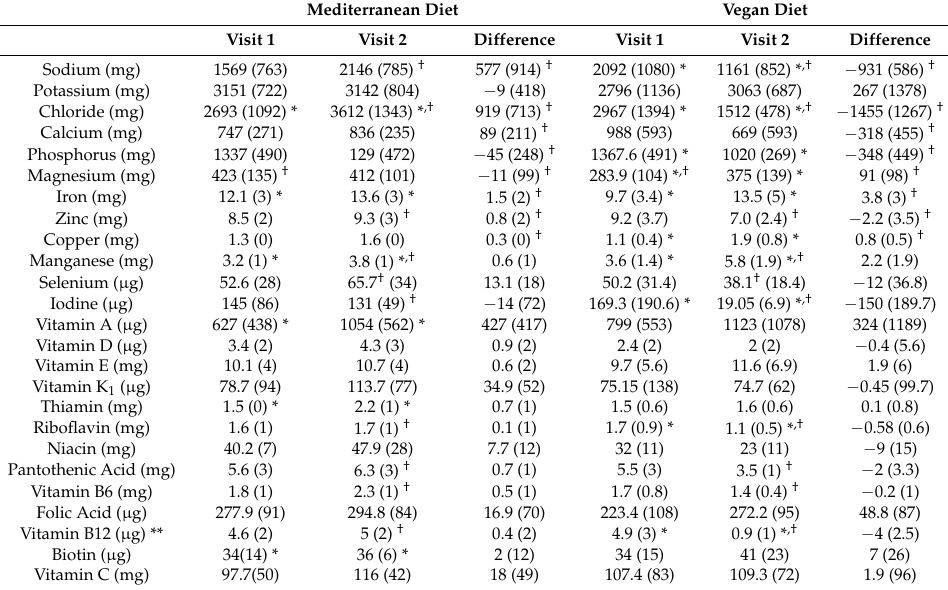
Table 5. Micronutrient